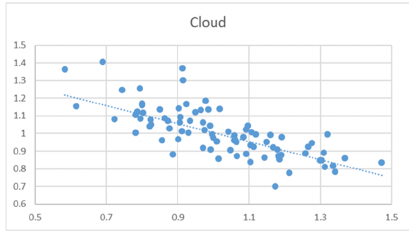
Figure A2. Normalized monthly mean cloud forcing (y-axis) vs. rest hour (x-axis) during 2010–2019 for New Delhi, Kathmandu, and Dhaka.